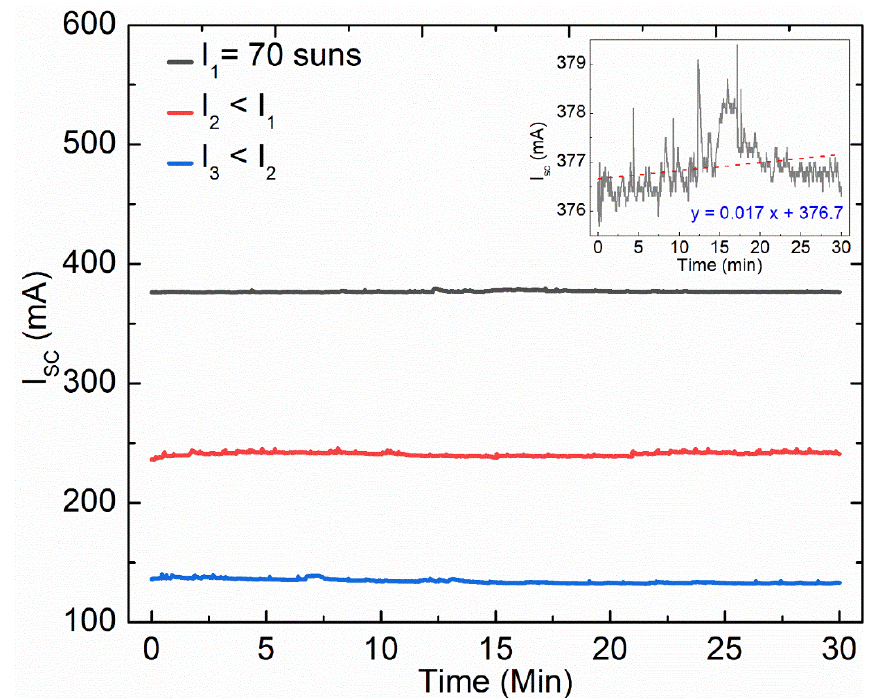
Figure 2. Short-circuit current of a solar cell as a function of time for the varying illumination of up to 70 × suns. The data are shown for the solar cell connected to the heat sink with non-curing TIM with 40 wt% of graphene fillers. The inset shows that the change in I SC with time, and thus with temperature rise, is negligible. As expected, the higher I SC values were observed at the optimum concentration of the illumination.